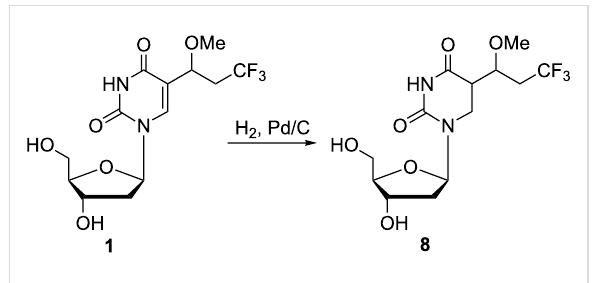
Scheme 2: Synthesis of 5-(3,3,3-trifluoro-1-methoxyprop-1-yl)-5,6- dihydro-2'-deoxyuridine ( 8 ).